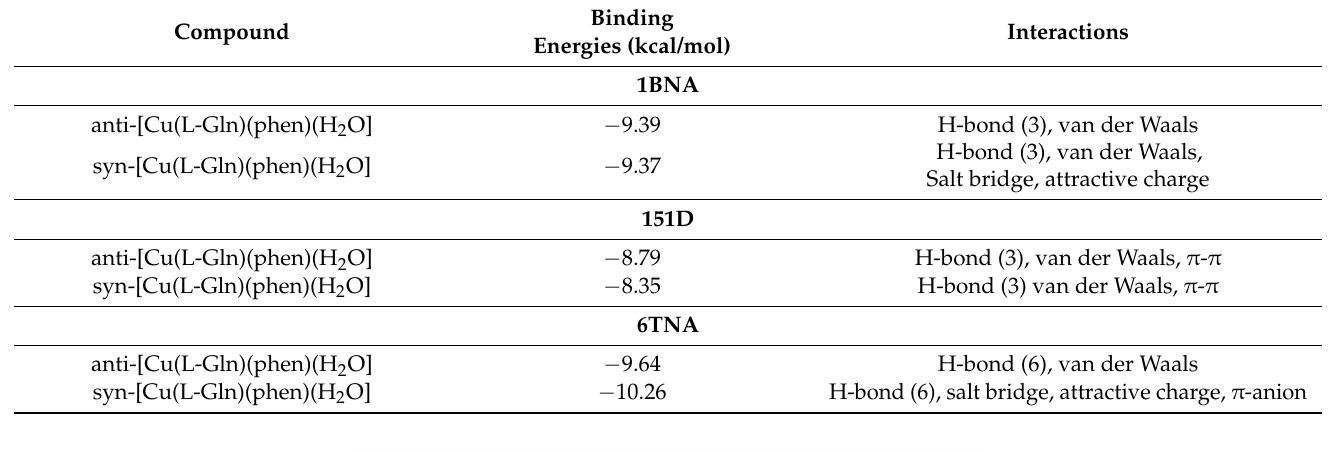
Table 4. Docking results, including the binding energies for the complexes’ best molecular poses between DNA and tRNA with the two copper complexes with glutamine.